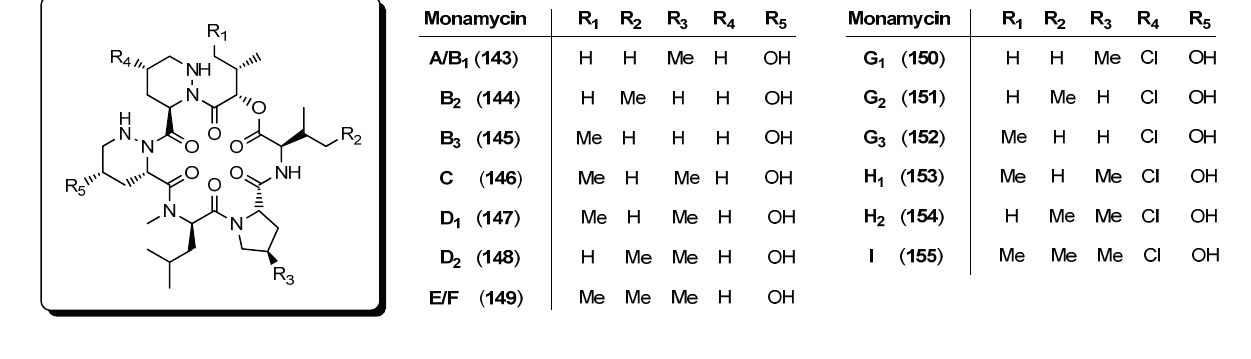
Figure 14. Structures of different monamycins 143 – 155